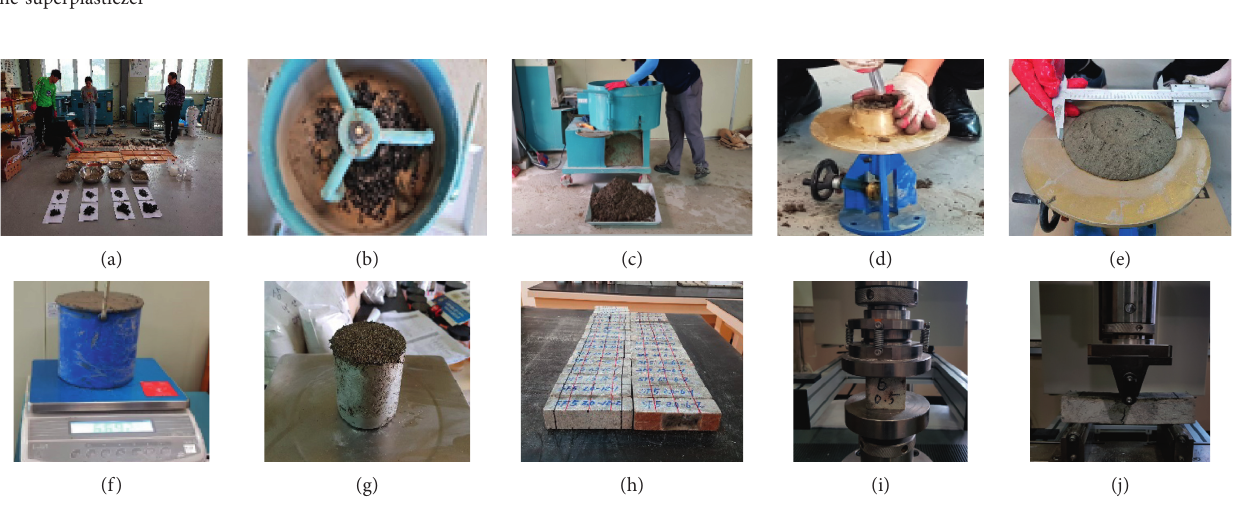
Figure 3: Main experimental process and casting progress of each step for manufacturing of CFRM composite specimens: (a) material metering, (b) fiber mixing, (c) finish mixing, (d) compaction, (e) flow test, (f) unit weight test, (g) air content test, (h) finish of specimens, (i) compressive test, and (j) flexural